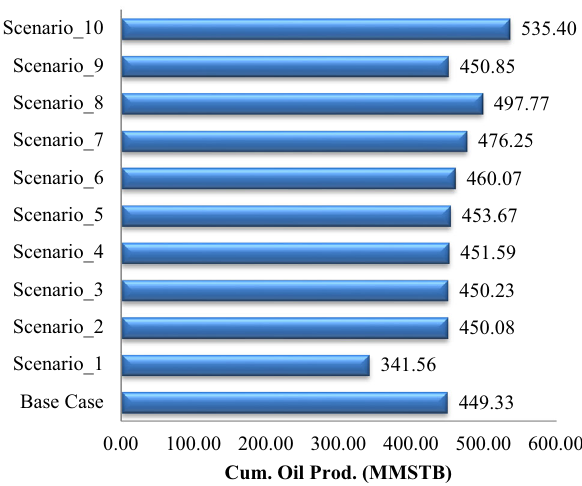
Fig. 22 Comparison of oil productions in different scenarios